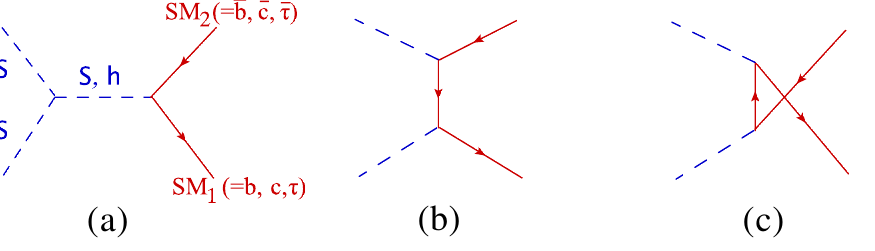
Figure 9 . Feynman diagrams that dominantly contribute to the DM annihilation cross section.